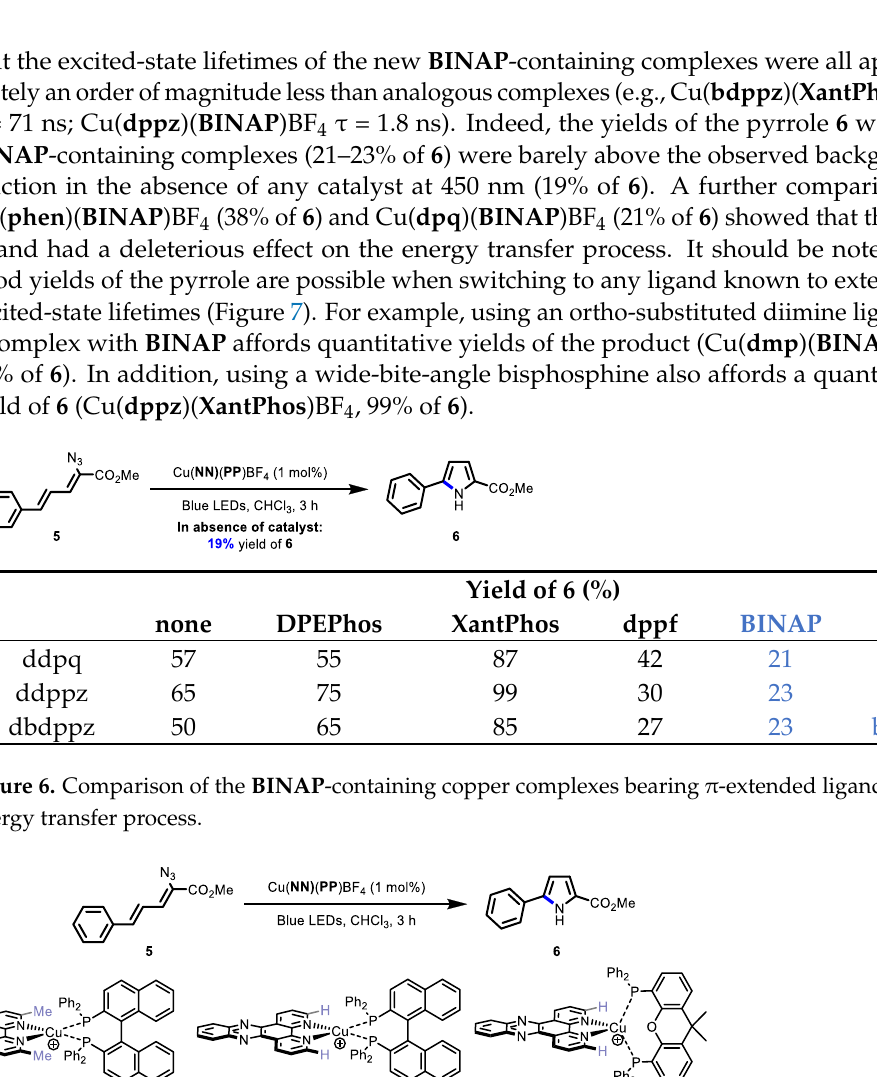
Figure 5. Comparison of the BINAP -containing copper complexes bearing π -extended ligands in a photochemical PCET process.